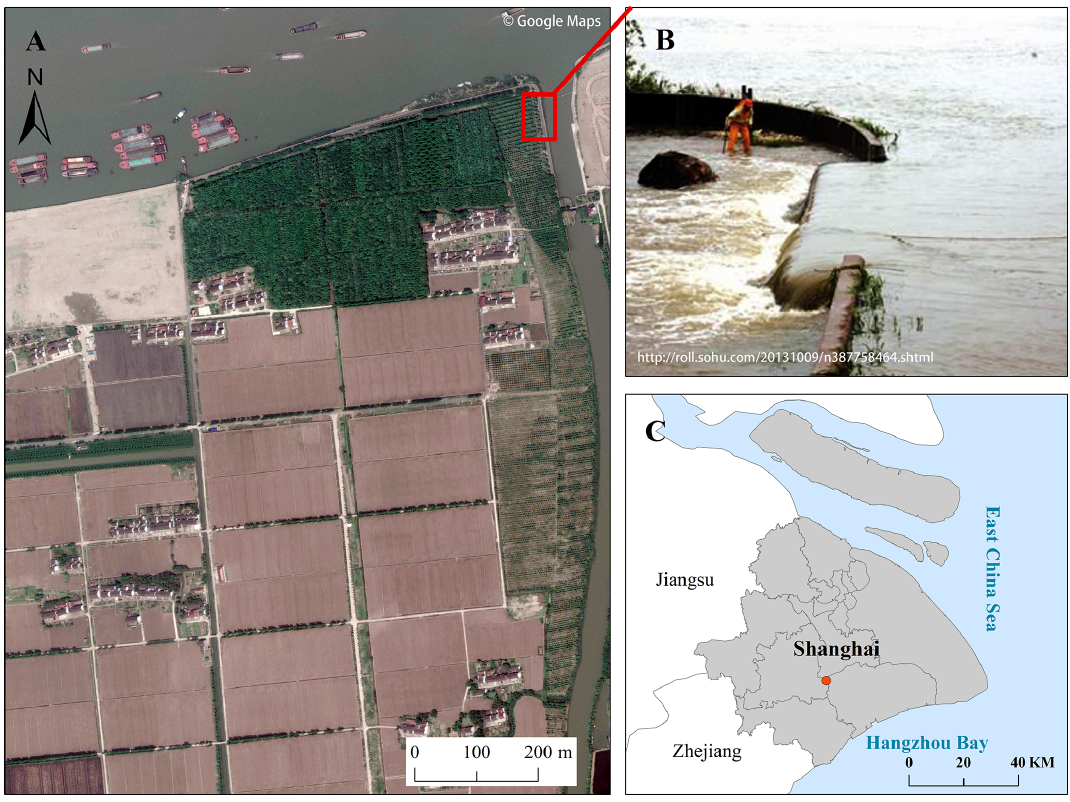
Figure 1. Location of the study area and levee breach during Typhoon Fitow.